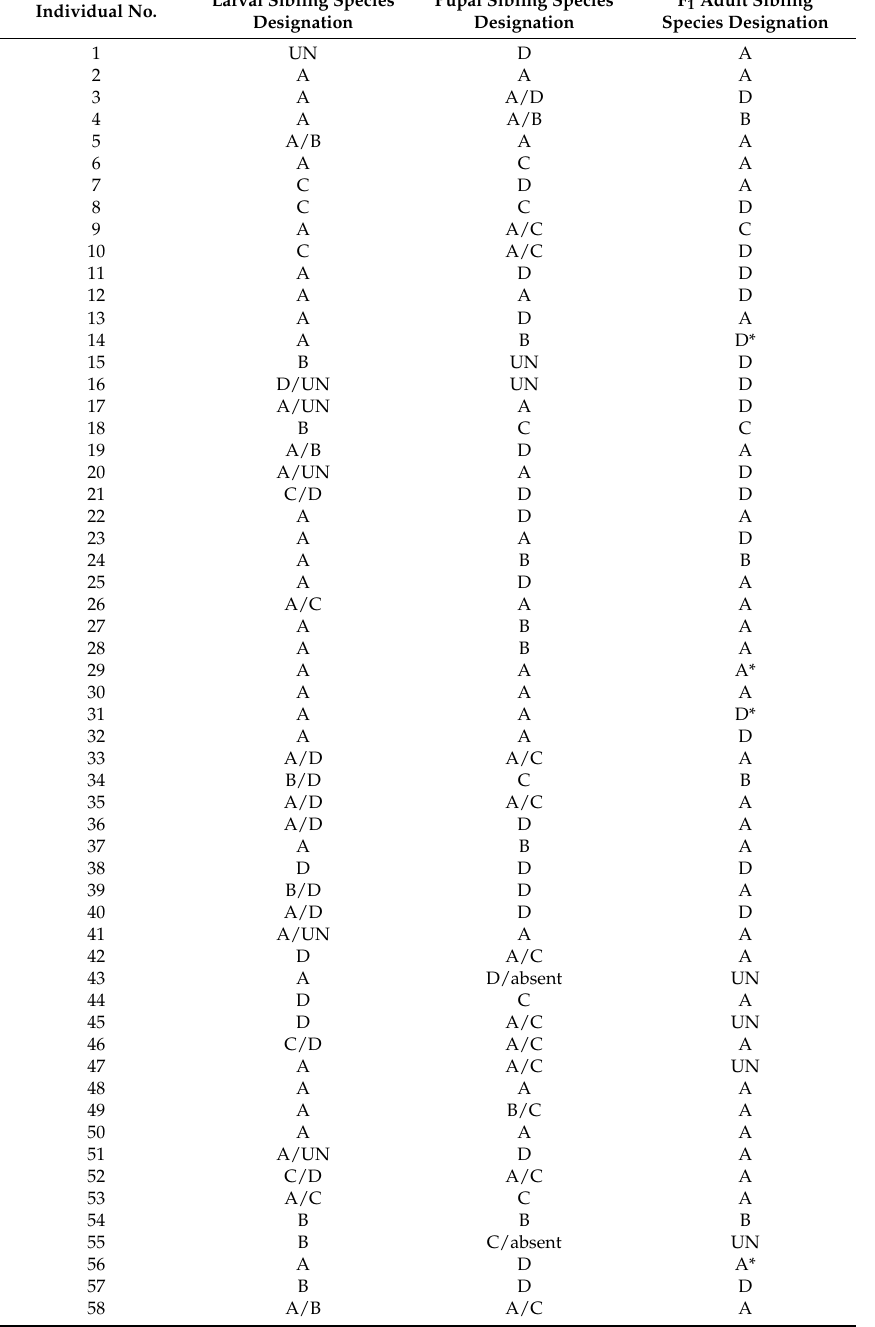
Table 6. Morphological identification of sibling species status of larvae, pupae, and F 1 adults of individual eggs in five isofemale